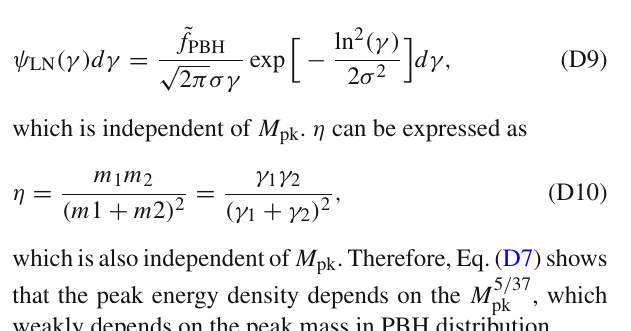
Fig. 9 The GW spectrum of a single PBH stellar bubble. The ˜ f PBH = 1 in the PBH stellar bubble, and the redshift of the bubble is set as z = 0 . 01. The extended mass distribution of the PBH is lognormal distribution with σ = 1 and M pk = 10 18 g , 10 21 and g , 10 24 g for red, orange, and blue shadow regions, respectively. The lower solid line and upper solid line denote the total PBH mass in the bubble which is set as 10 45 g and 10 48 g, respectively. Sensitivity curves below 1000Hz from SKA, LISA, BBO, and LIGO are plotted. Sensitivity curves in the ultrahigh-frequency range from OSQAR [90] and CAST [91] are also